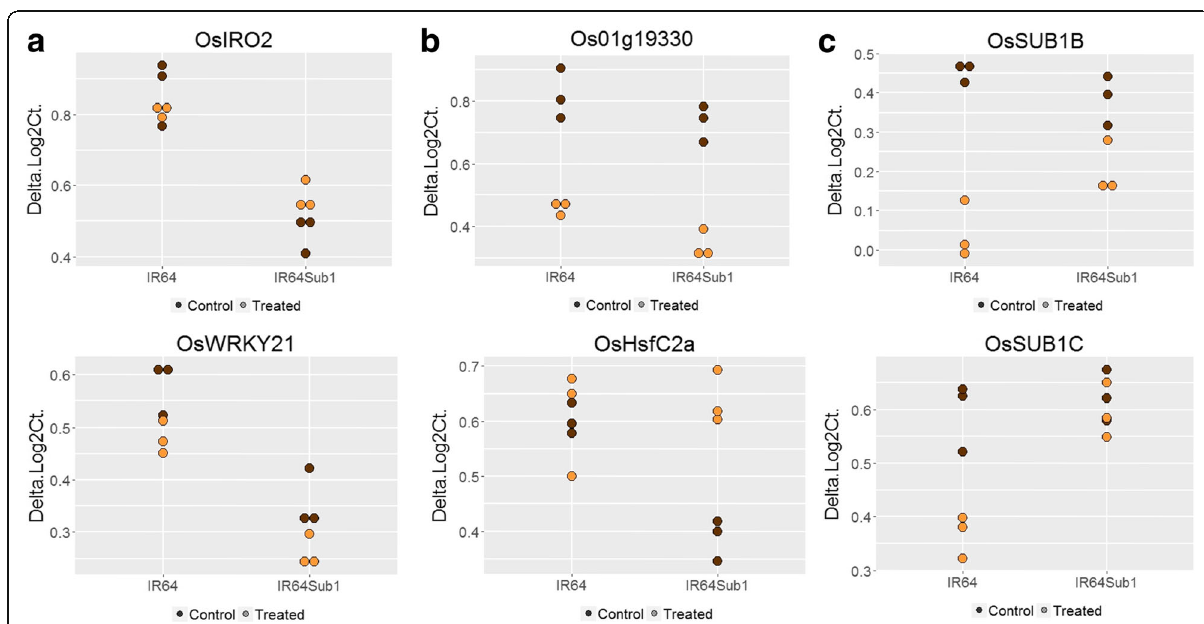
Fig. 2 Differentially expressed transcription factor genes in IR64 and IR64-Sub1. Representative dot plots are shown illustrating three different categories of DEGs: a Non-submergence-responsive genes with genotype-dependent differential expression, ( b ). submergence-responsive genes in IR64-Sub1, (c). and submergence-responsive genes in